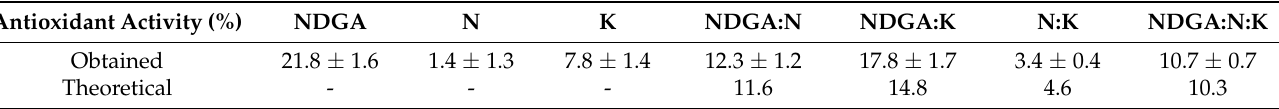
Table 4. DPPH radical-scavenging activities of natural compounds. NDGA (4 µ M), naringenin (N) (4 µ M), and kaempferol (K) (4 µ M), as well as mixtures of NDGA and N (2 µ M NDGA + 2 µ M N), NDGA and K (2 µ M NDGA + 2 µ M K), N and K (2 µ M N + 2 µ M K), and NDGA and N and K (1.3 µ M NDGA + 1.3 µ M N + 1.3 µ M K) (mean ± SD, n = 3).